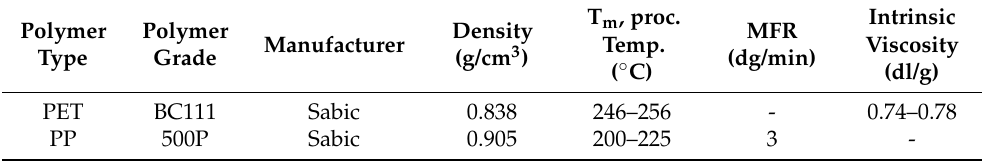
Table 1. Manufacturer’s datasheet of MFC-based